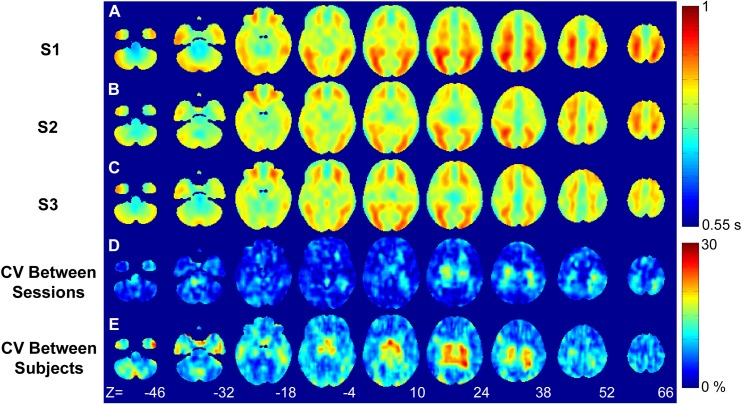
Whole brain group averaged (N = 7) arterial transit time maps for session 1 (A), session 2 (B), and session 3 (C). Voxel-wise between-session (D) and between-subject (E) coefficient of variance maps.